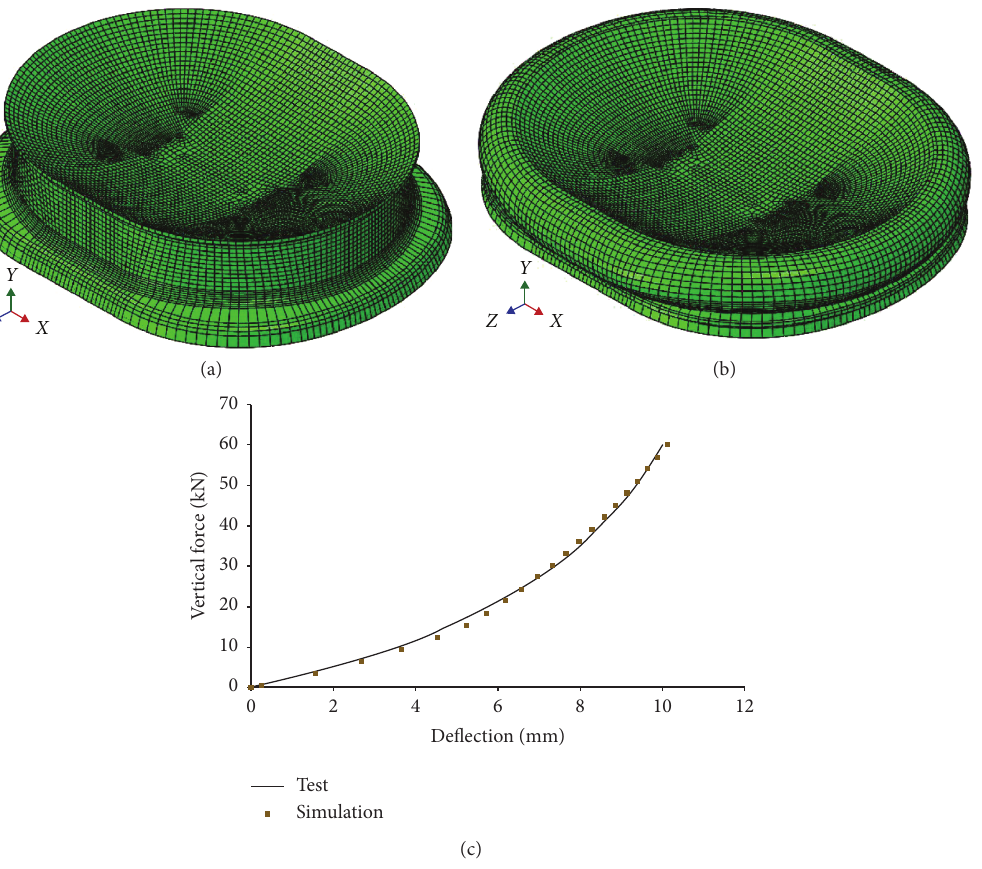
Figure 3: The finite-element model and deformed profile of the rail vehicle buffer with the load-deflection curve comparison. (a) The finite- element model of the rail vehicle buffer. (b) The deformed profile of the buffer under the vertical load 60kN. (c) The comparison of the load- deflection curves between the simulation and the experiment of the